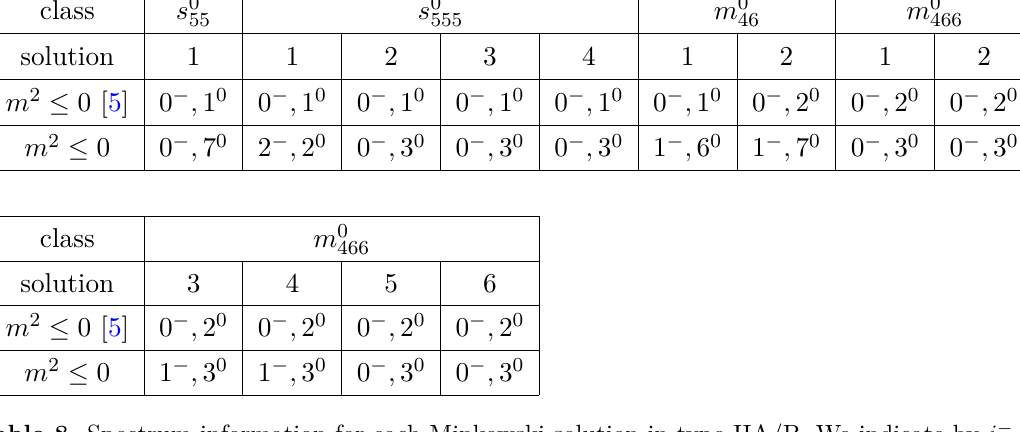
) as obtained in [5], I